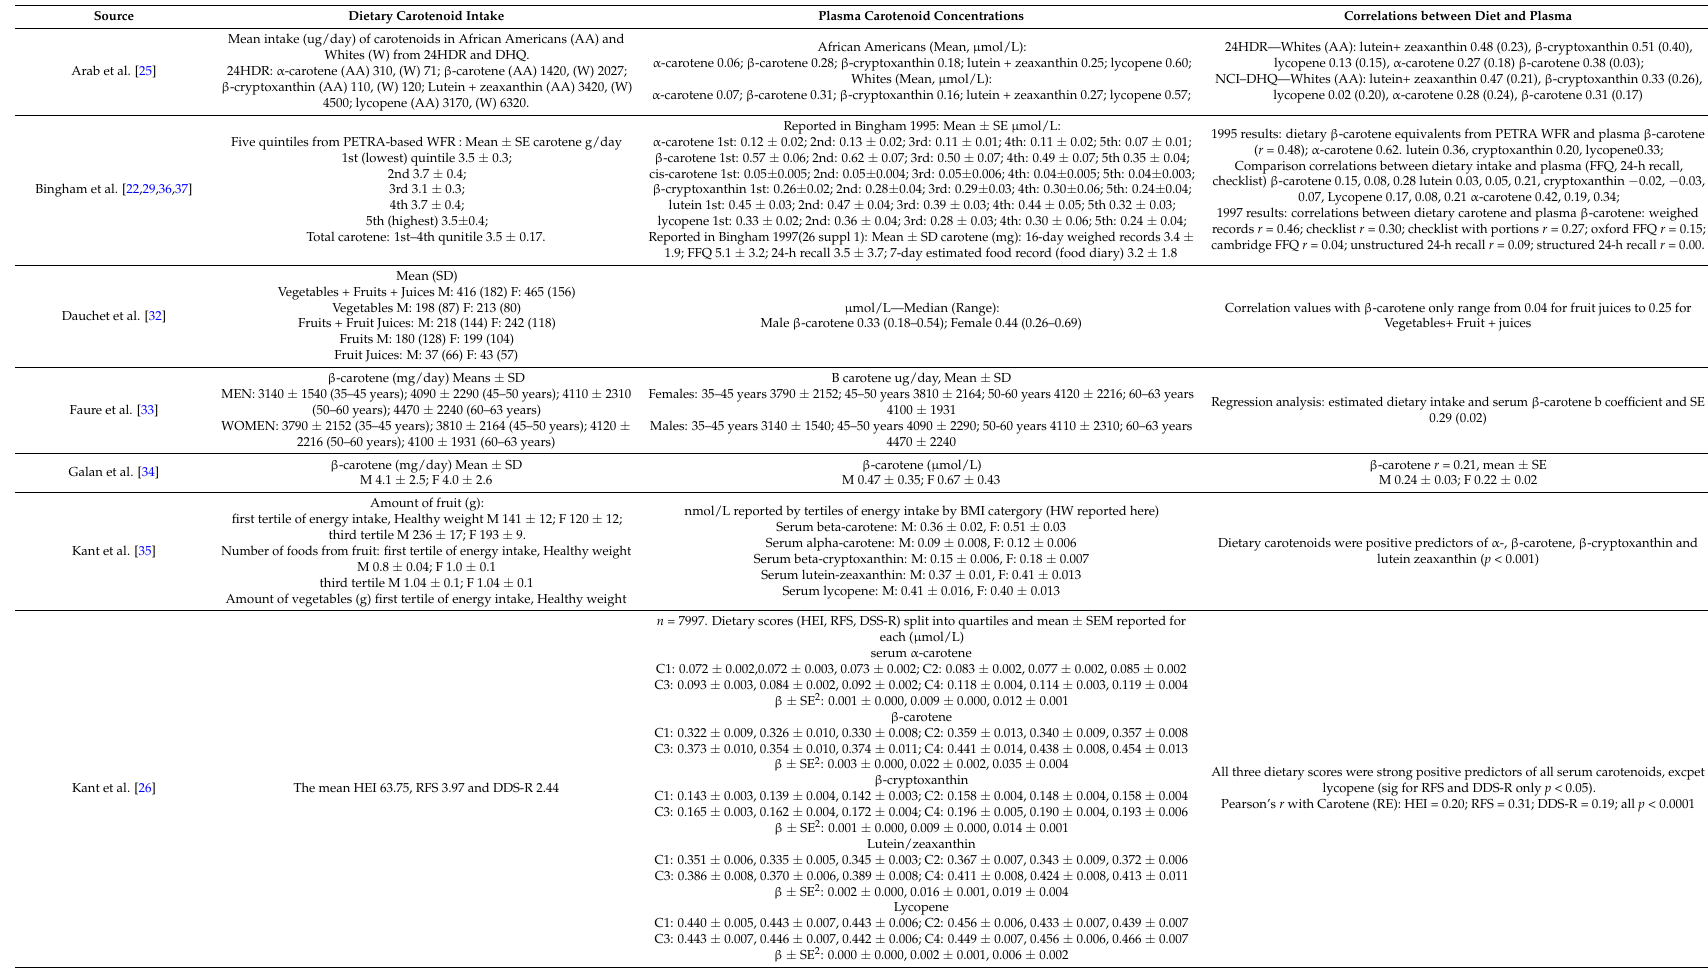
Table 3. Outcomes of Included